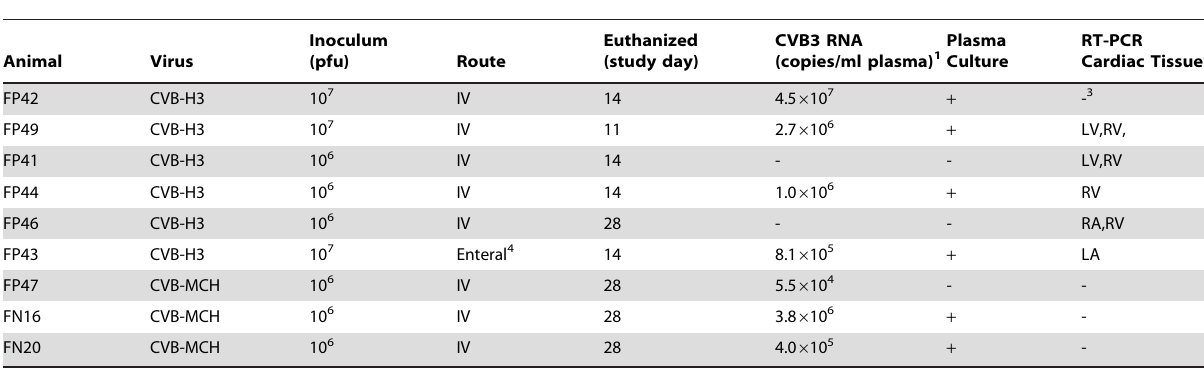
Table 1. Summary of Animals and Virologic Studies.